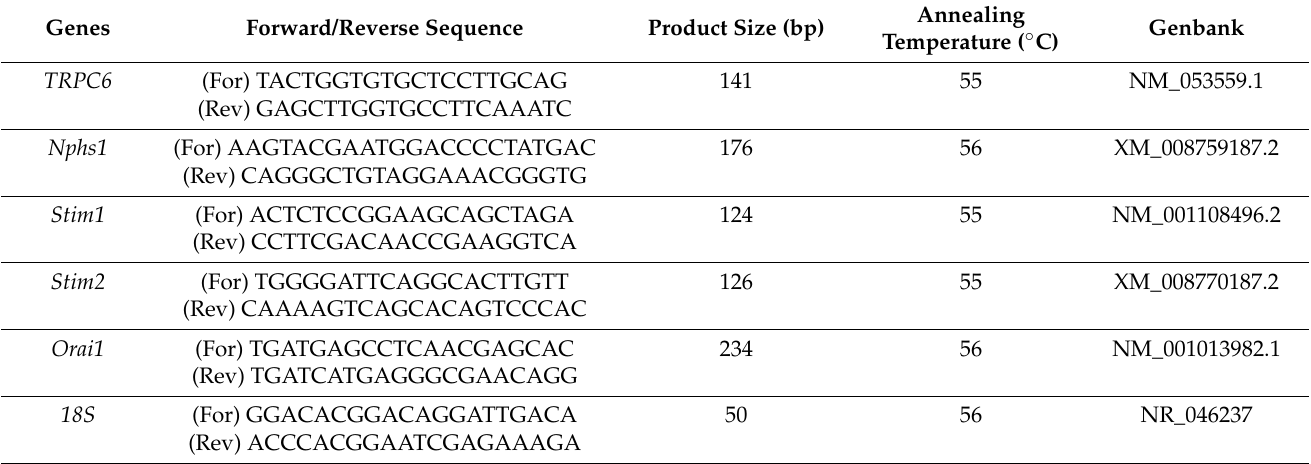
Table 2. The primers for the study of target and reference genes using real-time